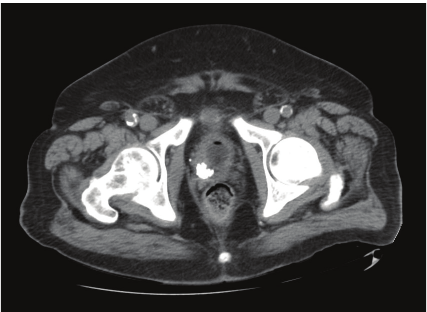
Figure 1: Axial image from the noncontrast pelvic CT scan demon- strating the right prostatic calcification measuring 17 × 12mm in this